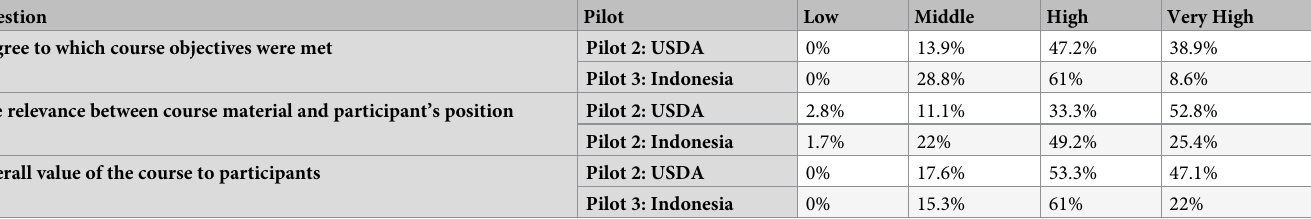
Table 3. Workshop evaluation results. General assessment of the OH-SMART workshop success based on participant feedback from pilot 2: USDA (N = 36) and pilot 3: Indonesia (N = 87).